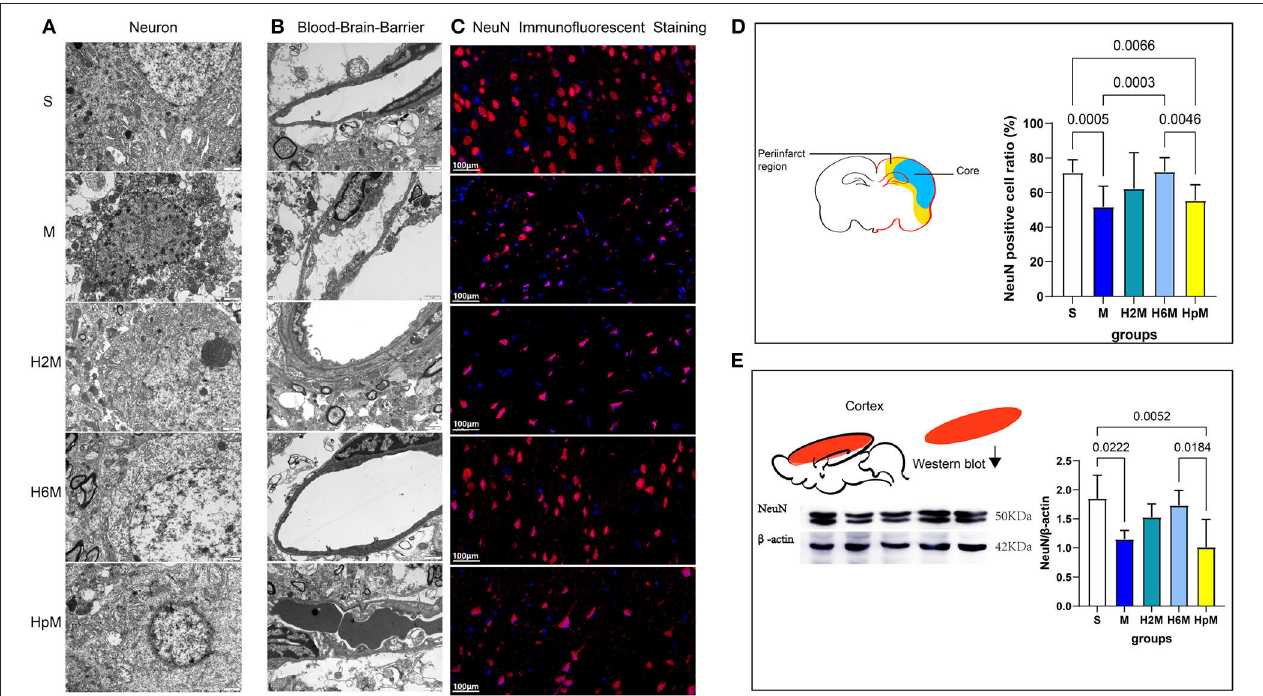
FIGURE 3 | Ultrastructural changes of neurons, blood-brain barrier in the periinfarct zone, and assessment of NeuN in the damaged brain tissue. (A) Transmission electron microscopic observation of neurons (15,000 × , 80 kV, n = 2). (B) Transmission electron microscopic observation of blood-brain barrier, vascular endothelial cells mainly (15,000 × , 80 kV, n = 2). (C) NeuN immunofluorescence staining in the periinfarct tissue (40 × ). (D) The diagram shows the periinfarct region and necrotic region (Core) of the MCAO rat’s brain section and the NeuN positive cell ratio (%) [NeuN positive cell ratio (%) = (NeuN positive cell number/DAPI positive cell number)*100%] in the periinfarct. One-way ANOVA showed differences among the five groups, F = 8.08, p < 0.0001. Results are presented as mean ± SD ( n = 5). ANOVA, analysis of variance; MCAO, middle cerebral artery occlusion; NeuN, neuron-specific nuclear protein. (E) Western blotting shows the results of NeuN in the damaged cerebral cortex. Statistical results of NeuN western blotting and mean gray value analysis of damaged cerebral cortex. One-way ANOVA showed differences among the five groups, F = 6.12, p = 0.0022. Results are presented as mean ± SD ( n = 5).